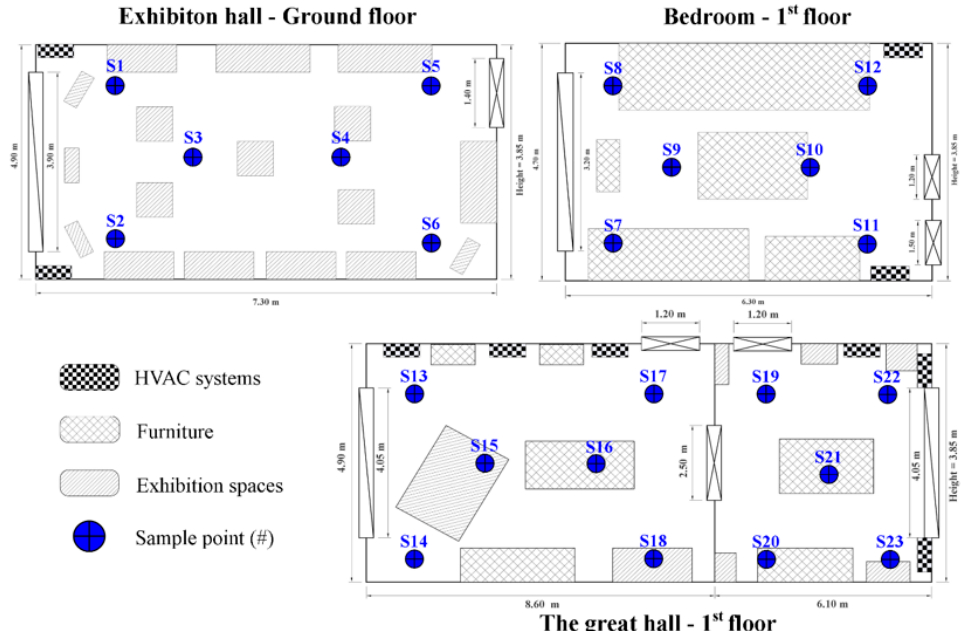
Figure 2. Spatial distribution of the sampling points for the assessment of the fungal load within the three analyzed rooms in Darvas-La Roche House .